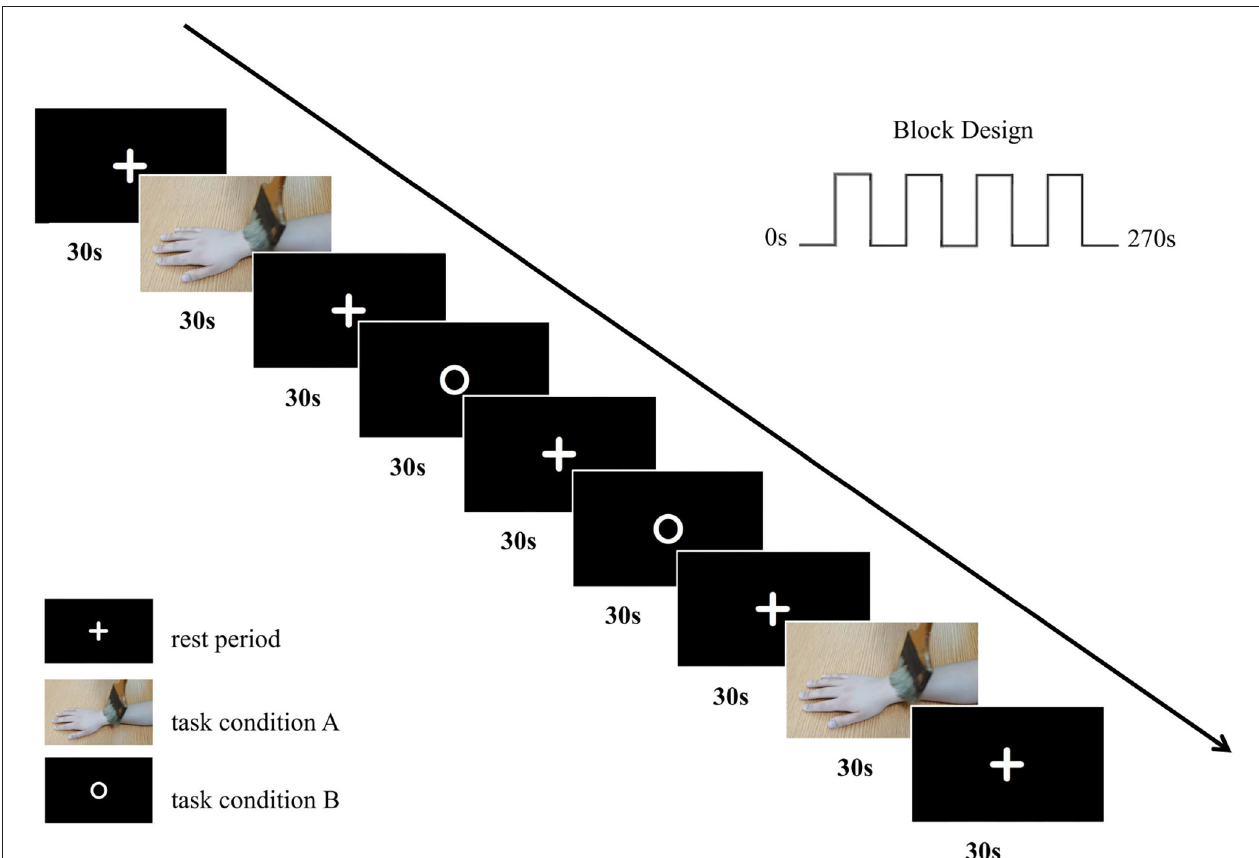
FIGURE 1 | The basic fMRI experimental scheme. We adopted a block design with two conditions in our fMRI experiment with an ABBA task sequence.